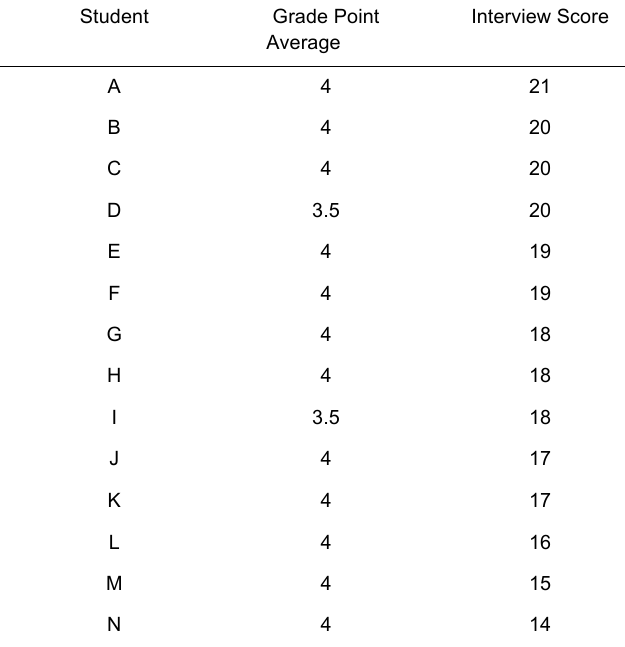
Table 4. Student Grade Point Averages and Interview